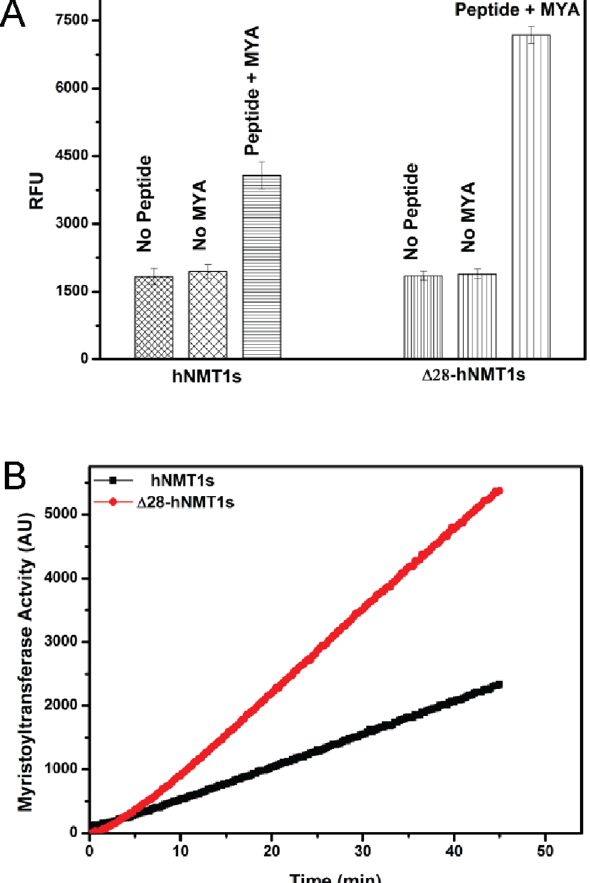
Fig 4. Comparison of the effects of N-terminal deletion on myristoyltransferase activity. A , Biochemical analysis of the enzymatic property of hNMT1s and Δ 28-hNMT1s. Purified enzymes (5 nM) were assayed in standard reaction as described under “ Materials and methods ” . The resultant increase in fluorescence ( λ ex 384 nm, λ em 470 nm) was quantified in presence or absence of either of the substrates in an assay time of 30 min at 25°C. Enzyme activity is expressed as relative fluorescence units (RFU) generated in the reaction. Values represented are mean ± S.D of triplicate measurements. B , Enhancement of the myristoyltransferase activity by N-Terminal deletion. Myristoyltransferase activity was monitored by the purified enzymes (5 nM) at saturating concentration of both substrates (30 μ M each) in 200 μ l of buffer containing 20 mM sodium phosphate (pH 7.5), 0.5 mM EDTA, 0.5 mM EGTA and 0.1% (v/v) Triton X-100. The fluorescence signals ( λ ex 384 nm, λ em 470 nm) generated were recorded progressively at 15-s interval and are reported over the linear range of responsiveness. The represented kinetic traces are the average of three measurements after subtraction of blank signals (reactions performed in the absence of the acceptor peptide